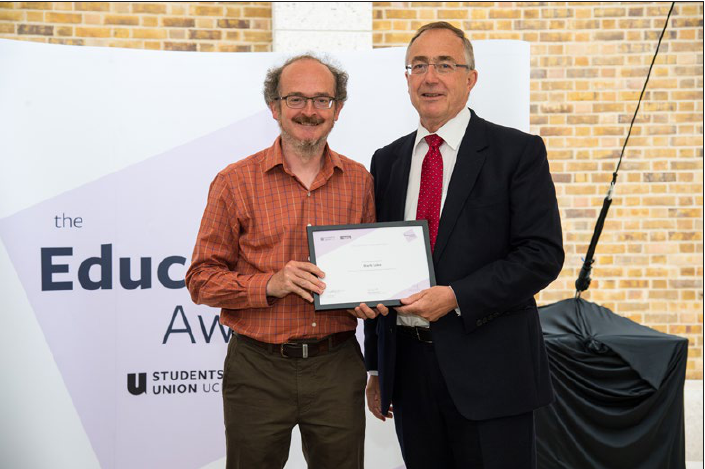
Figure 6 : Mark Lake receiving his UCL Education Award (Photo: K. Holst/UCL